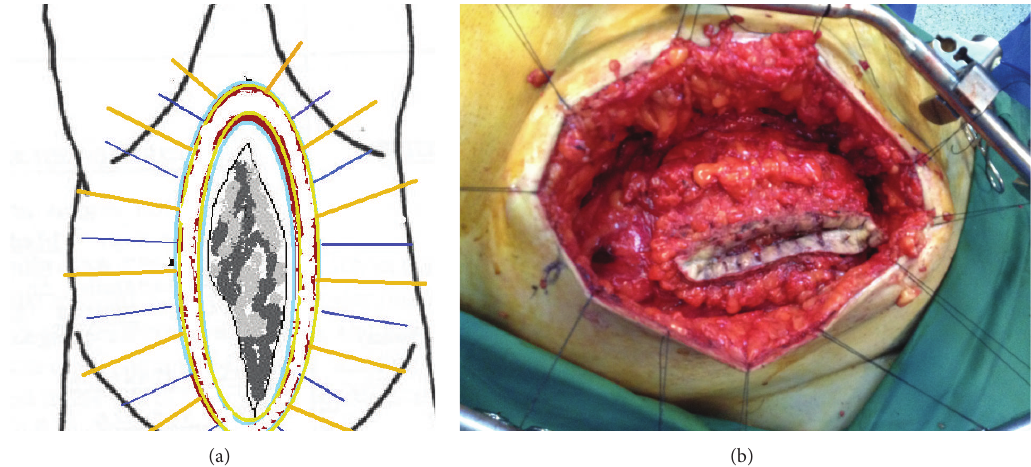
Figure 3: New elliptical incision and suspension of the aponeurotic leaf of external oblique abdominal muscle under traction. Lateralization of dissection and component separation technique